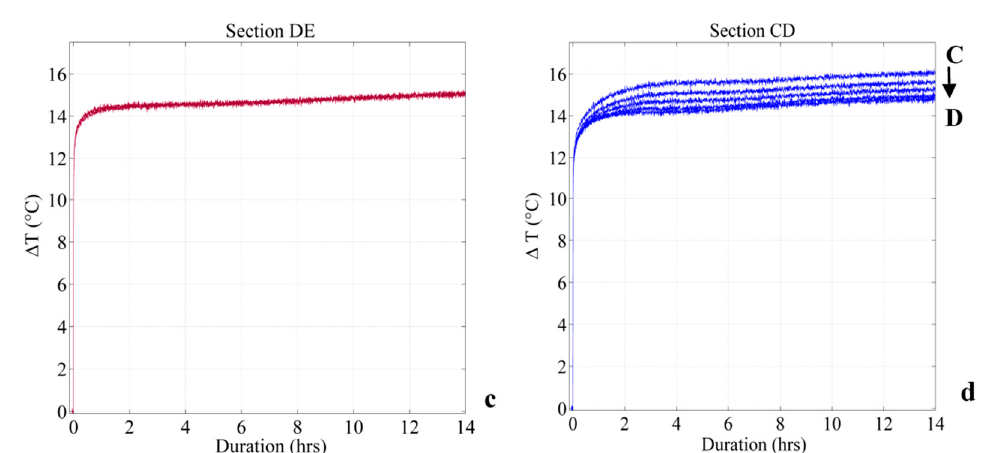
Figure 3. ( a ) Schematic top view of the deployment of the fiber-optic cable in the sandbox. Temperature is recorded from point A to point J. The di ff erent cable sections were highlighted by di ff erent colors. Dots along the cable represent the localization of measurement points recorded with the Ultima S DTS (Distributed Temperature Sending) unit. Electrical / fiber-optic cable connections are represented by black rectangles (C 1 and C 2 ). Black numbered dots represent PT100 probes installed in the sandbox. ( b ) Temperature profiles recorded with the Ultima S DTS unit along the heated section during the first heating period. The brown line corresponds to the temperature profile recorded after the first two minutes of heat injection. All other lines (gray and colored lines) highlight the temporal variability of temperature profiles after temperature stabilization (more than 4 h of heating) and correspond to temperature profiles recorded one after the other at sampling interval (20 s) during 4 min. The di ff erent cable sections were highlighted on the temperature profile with the same colors as (a). ( c ) Evolution of ∆ T over time during the third heating period along the section DE. The three external points were removed here. ( d ) Evolution of ∆ T over time during the third heating period along the section